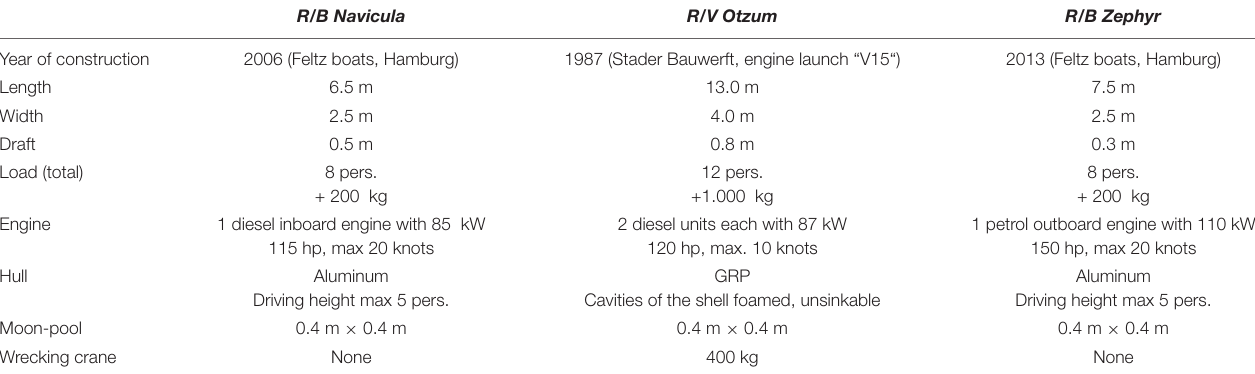
TABLE 2 | Technical specifications of R/B Navicula, R/V Otzum, and R/B